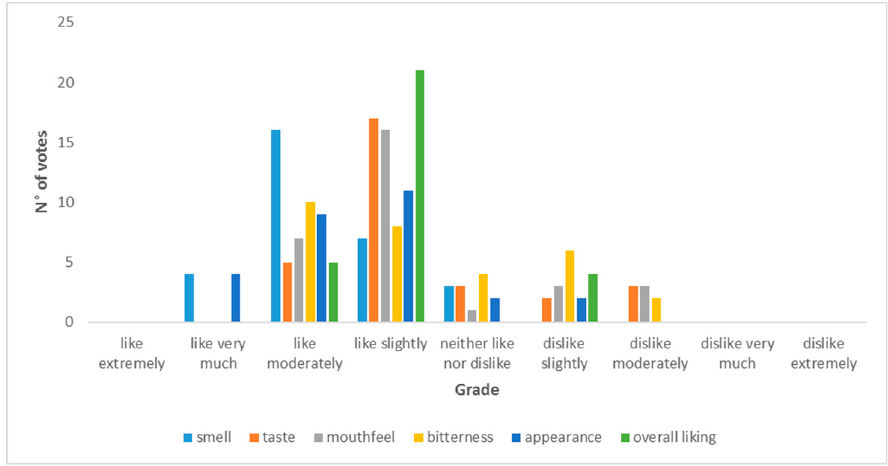
Figure 12. Hedonic nine-point scale grading for beer 3 (50% lactose and 50% coffee).